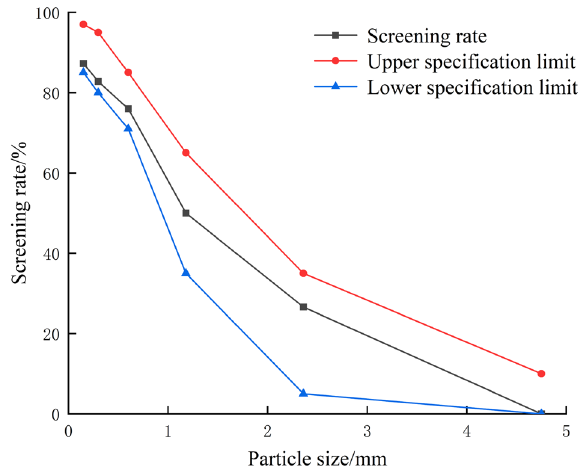
Figure 2: Grading curve of FA.